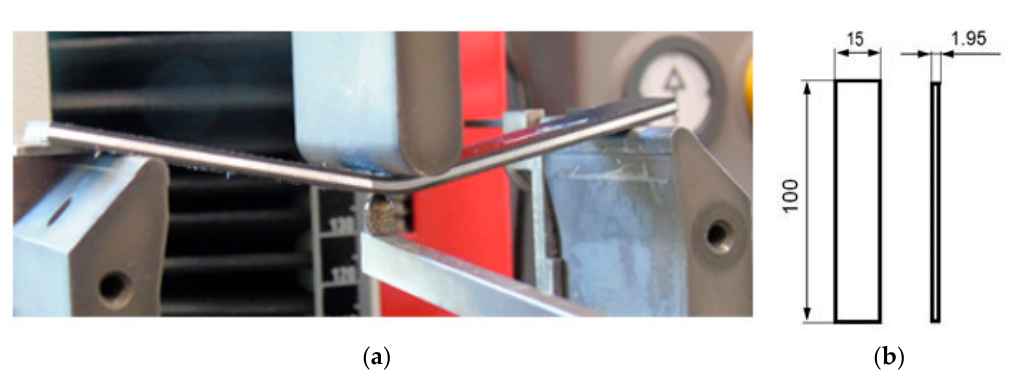
Figure 1. ( a ) Three point bending test set and ( b ) sample dimensions in accordance with DIN EN ISO 14125.